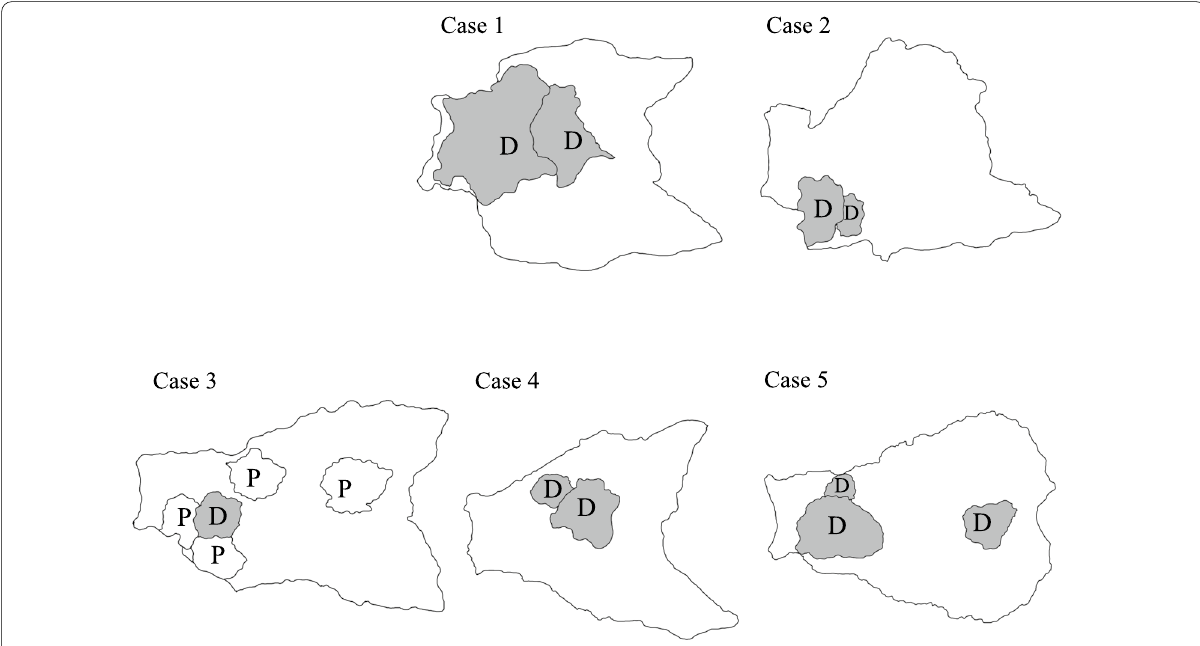
Fig. 5 Schematic distribution and deficient/proficient mismatch repair protein (MMR) of 14 gastric cancers. D deficient MMR, P proficient